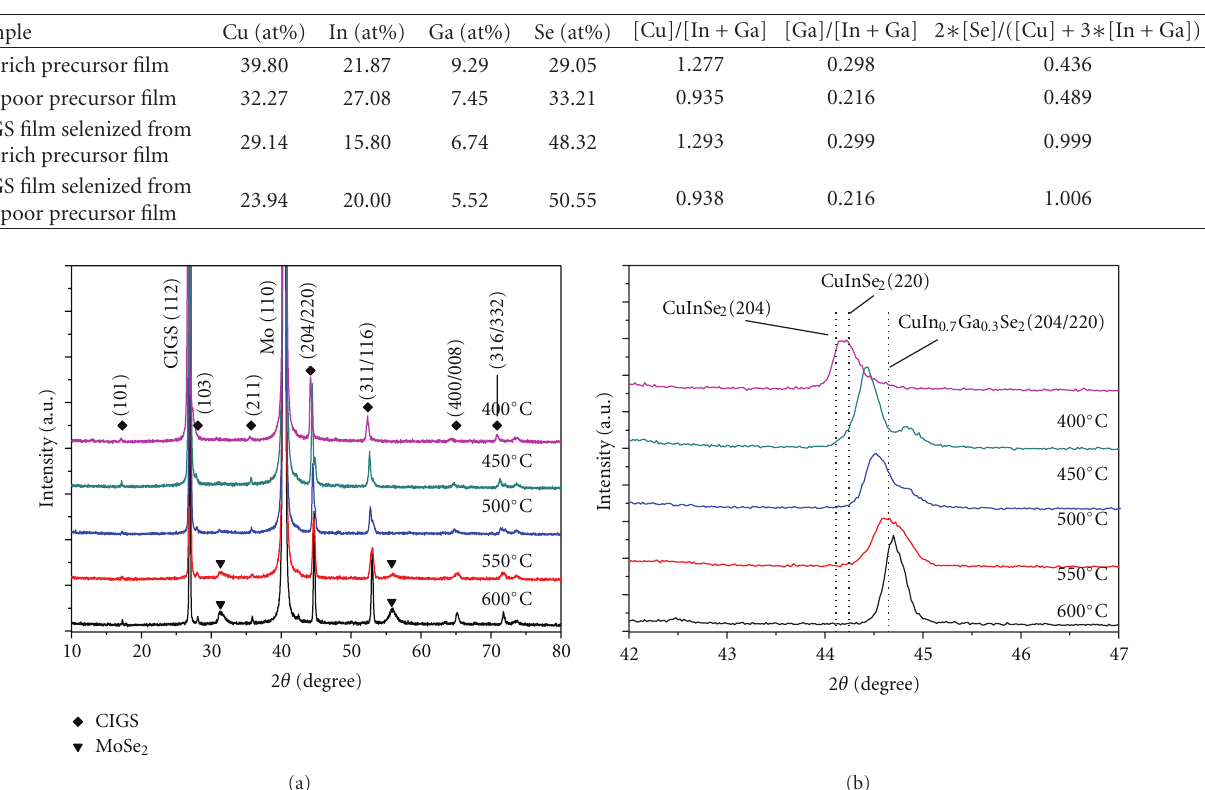
Table 1: Chemical compositions (measured by XRF) of the precursor films and subsequent selenized films at 550 ◦ C for 30min. Sample